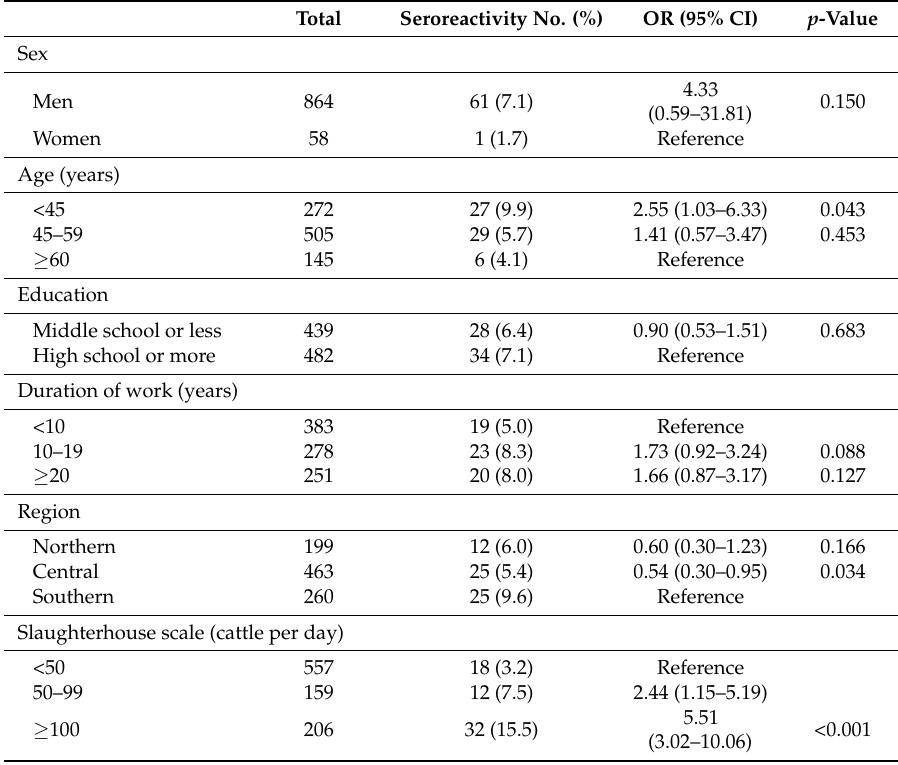
Table 1. Univariate logistic regression analysis of the demographic characteristics associated with brucellosis seroreactivity among cattle slaughterhouse workers in South Korea.